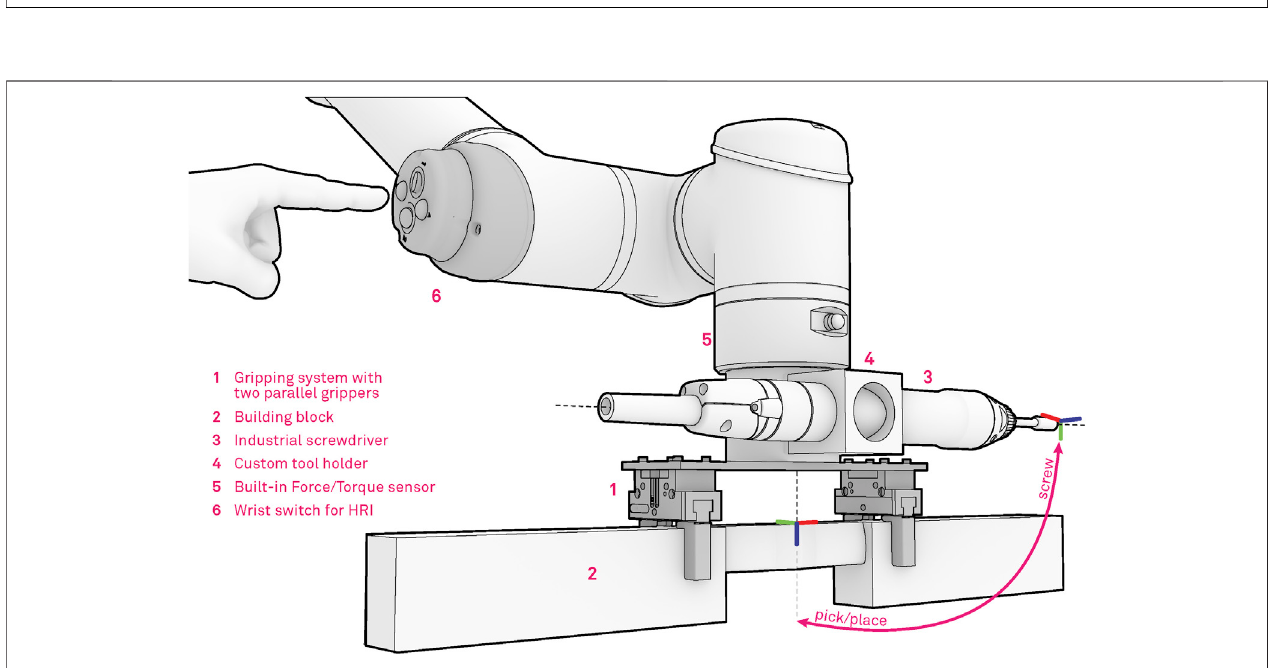
FIGURE 5 | Robotic tool for timber assembly, consisting of two parallel industrial pneumatic grippers, automatic screwdriver and the HRI interface.